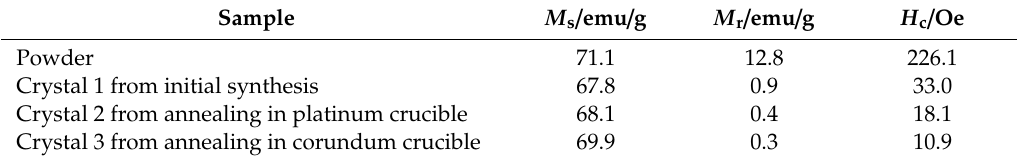
Table 6. Saturation magnetization M s , remanence M r and coercivity H c of four investigated samples.